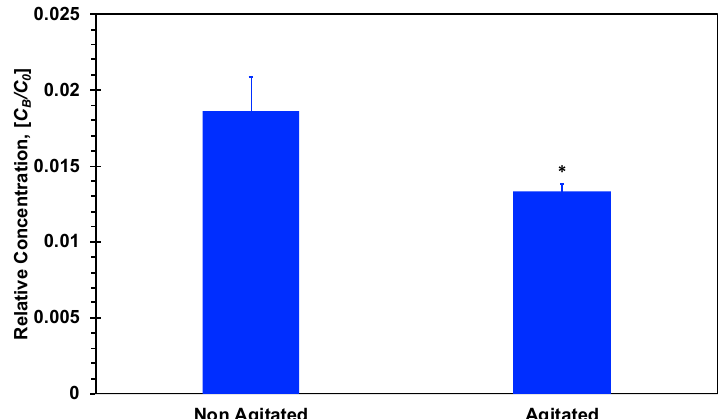
Figure 10. Bottom compartment relative concentration of insulin after 20 min incubation. Agitated insulin was agitated with an air–liquid interface for 5 min and then added to the upper Transwell compartment. * p < 0.05 compared with non-agitated insulin.